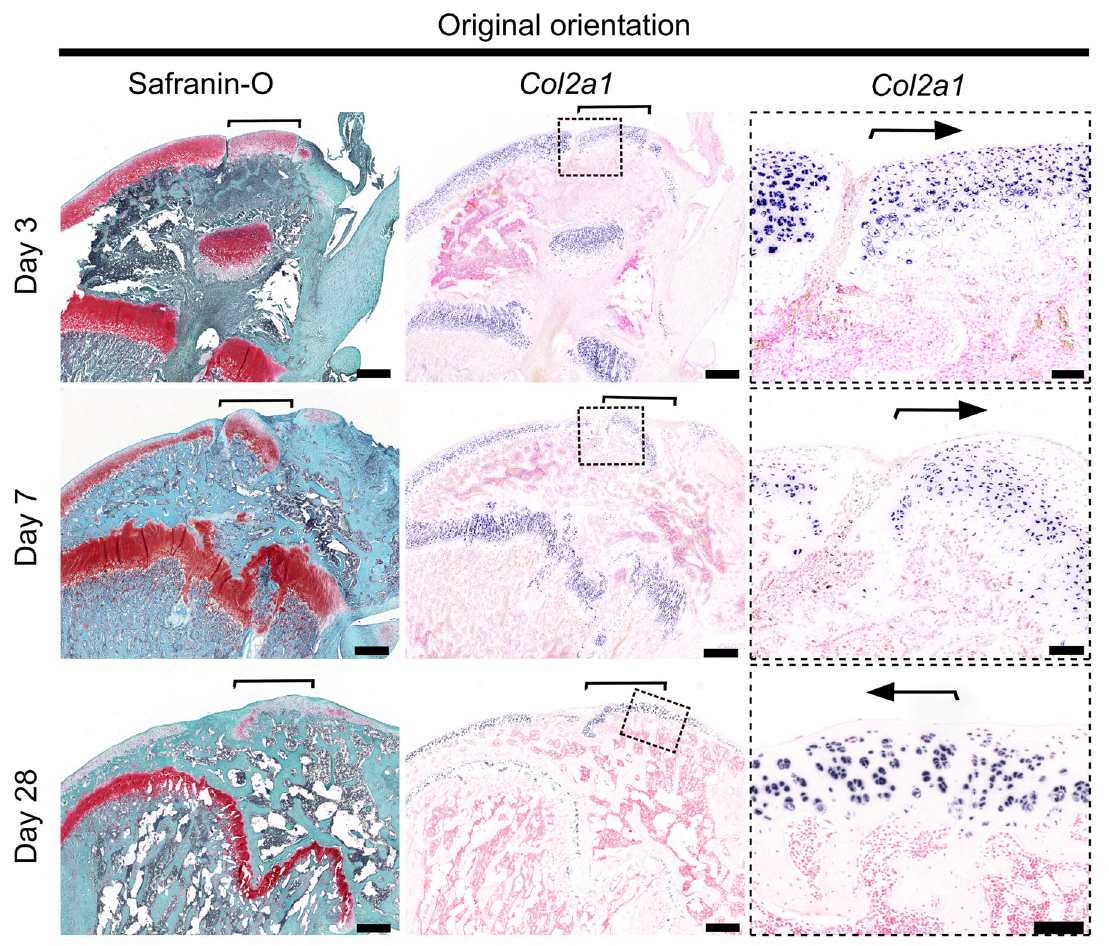
Fig. 6 Proteoglycan content and Col2a1 expression were maintained in transplants inserted in original orientation. Osteochondral allografts consisting of articular cartilage, epiphyseal bone, and growth plate cartilage from distal femurs of inbred GFP-expressing rats were transplanted to matching sites in wildtype (GFP-negative) littermates in original orientation (control). Proteoglycan content was visualized by Safranin-O staining (red) in sections of distal femur in low power, and Col2a1 expression by non-radioactive digoxigenin in situ hybridization at postoperative day 3, 7, and 28 and visualized in low and high power. Brackets and arrows indicate the location of the transplanted allografts. Scale bar: 100 μ